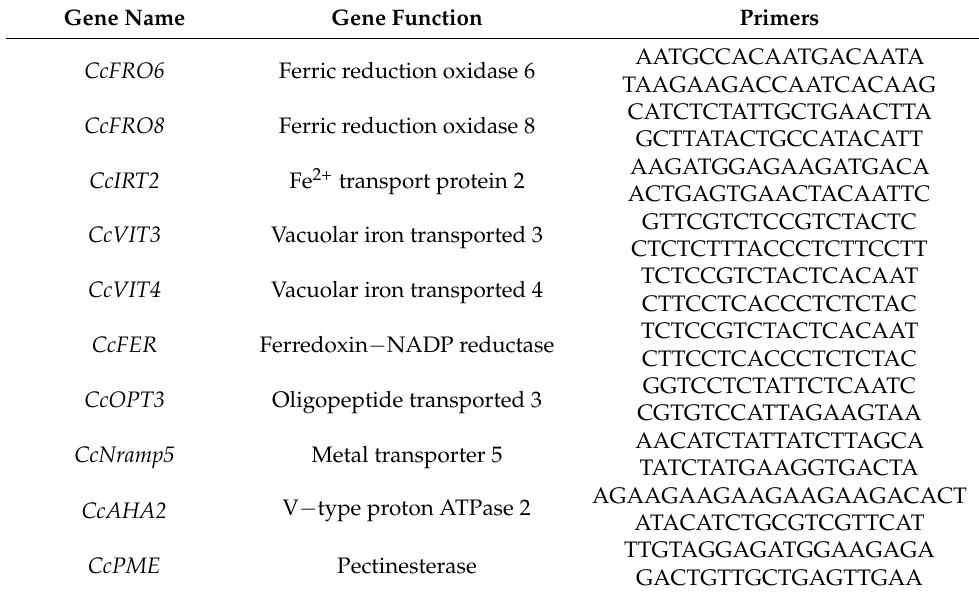
Table 1. Primers used in RT–qPCR